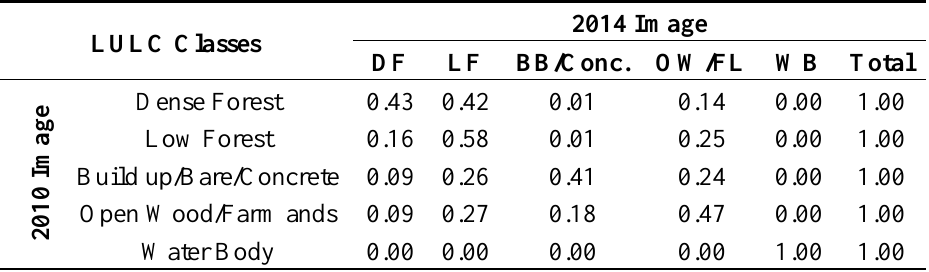
Table 7. Land use transition probability matrix from 2010 to